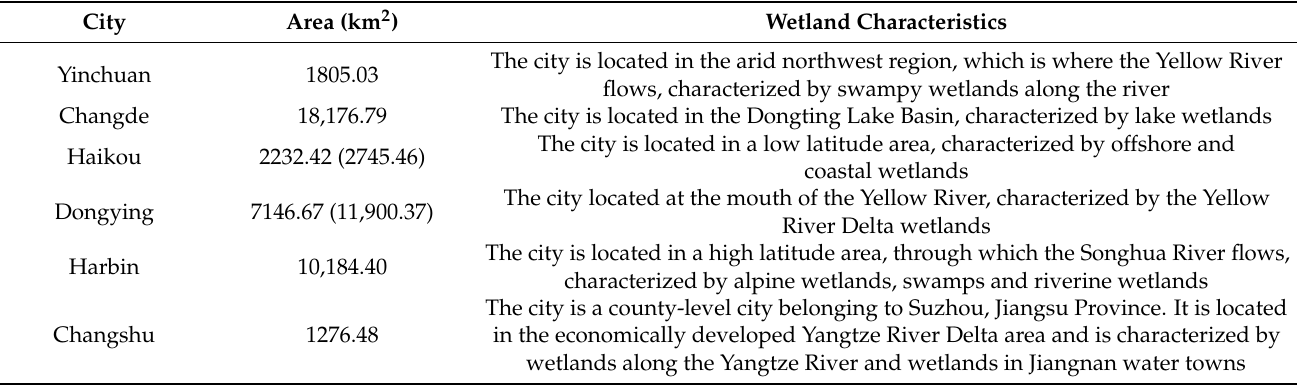
Table 1. Area and wetland information about Chinese wetland cities (the area of brackets indicates the area, including coastal extension